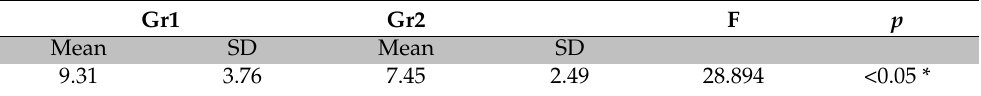
Table 6. Impact of between factor (group) on task 2 (SE). Effect of between factor (group) on task 2 (SE).